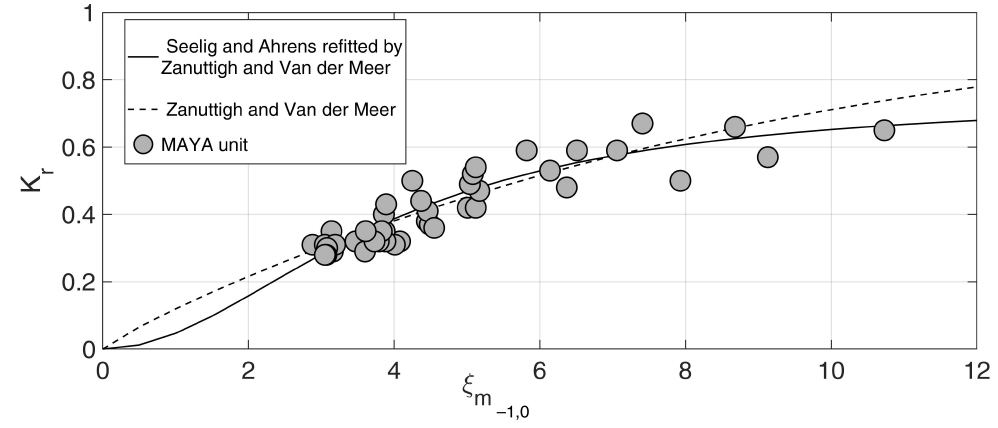
Figure 10. Comparison of MAYA armor units with the curves by Seelig and Ahrens refitted by Zanuttigh and Van der Meer (solid line) and Zanuttigh and Van der Meer (dotted